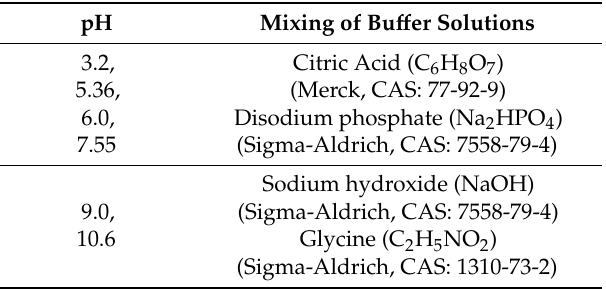
Table 2. Used bu ff er solutions for di ff erent pH values